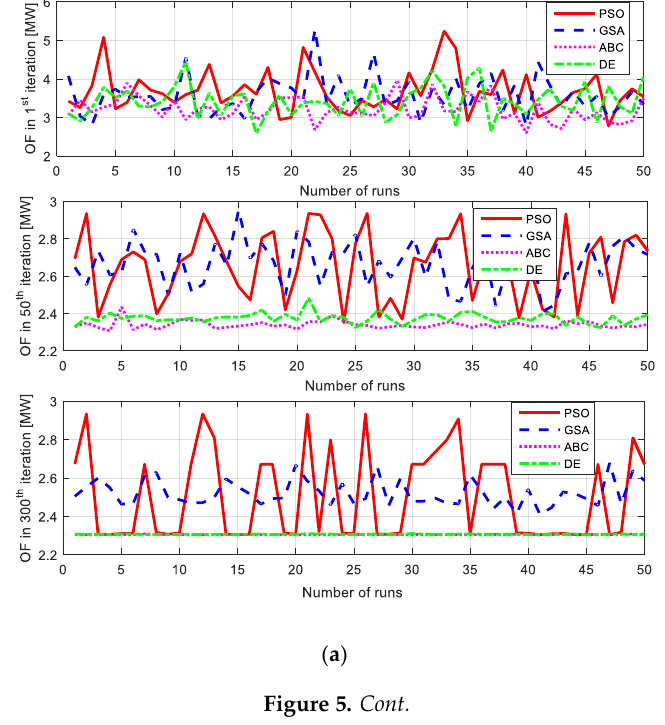
Figure 4. OF convergence—Max, Min, and Mean of all runs for the IEEE 9 test system.